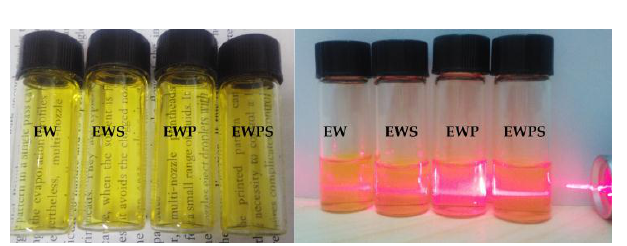
Figure 1. Images of sols of EW, EWS, EWP, and EWPS. All of them are transparent, colloid (Tyndall effect), and orange-yellow, which indicates that PEO and TEOS were uniformly dissolved in the sol.